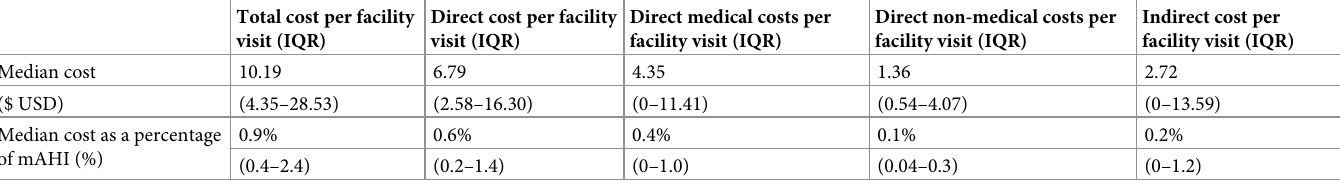
Table 2. Participant costs per facility